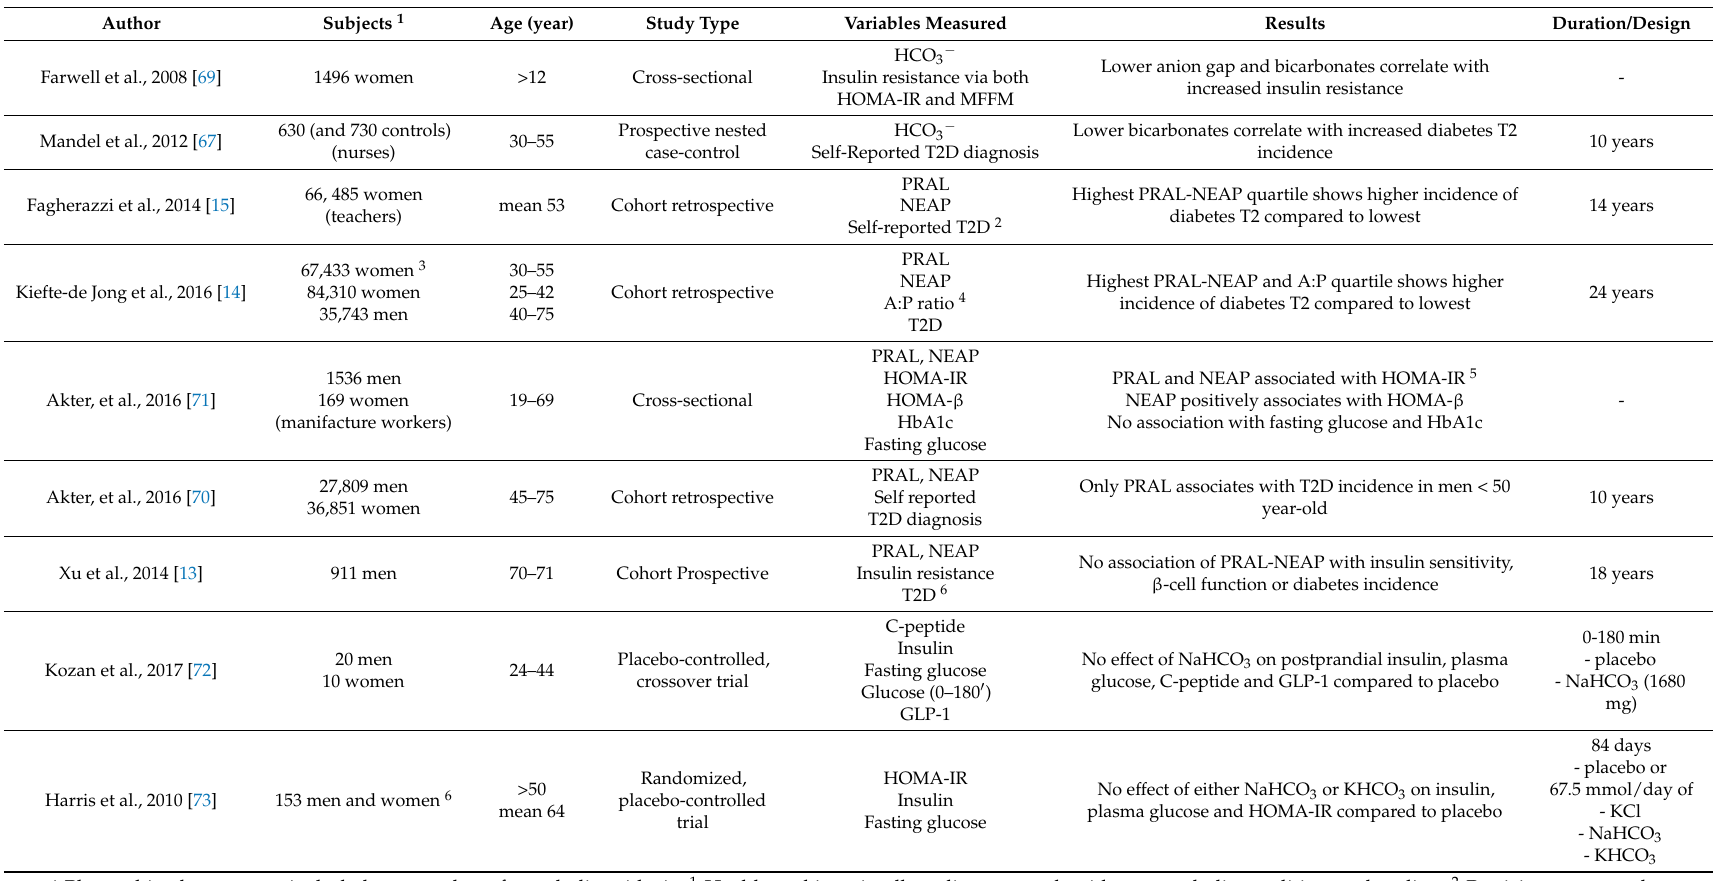
Table 3. Synopsis of the studies investigating the correlation of markers of acid load with insulin resistance and diabetes